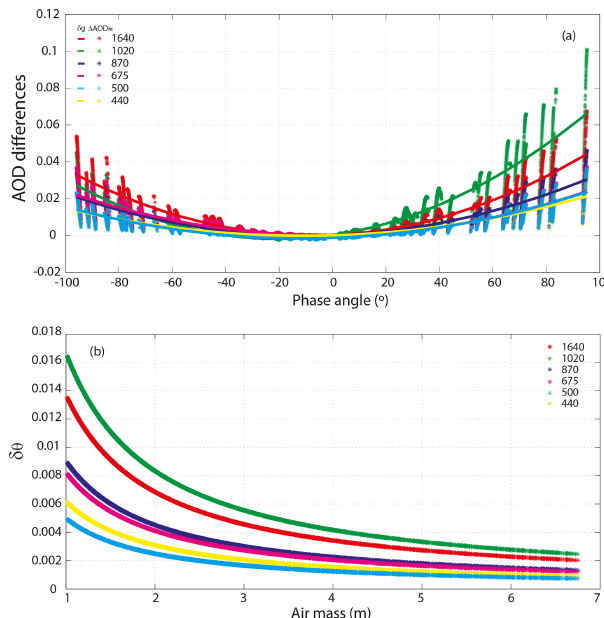
Figure 3. (a) AOD differences between daylight interpolated and nighttime measured values ( (cid:49) AOD fit with data points) and AOD differences predicted from the fitting analysis with the Moon’s phase angle ( δ g with colored lines). (b) AOD differences predicted from the fitting analysis with the Moon’s zenith angle ( δ θ